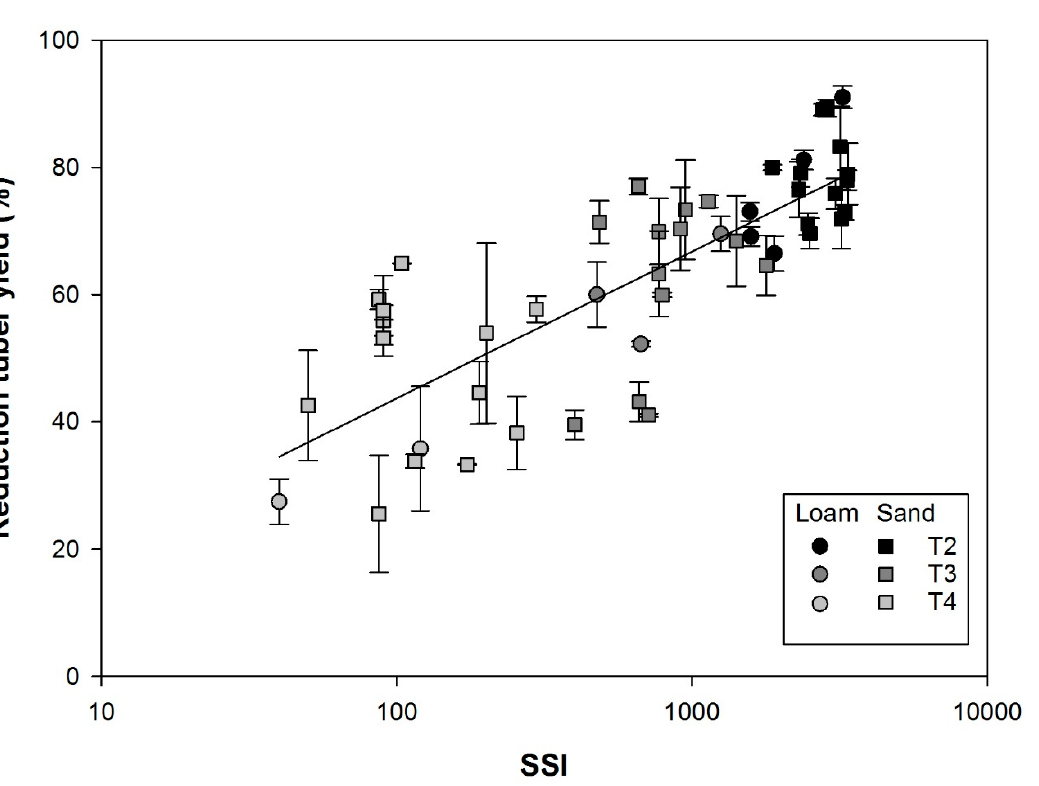
Figure 6. Stress severity index and tuber yield reduction relative to fully irrigated yields for all genotypes (Appendix B), both soil types (Appendix A, and all irrigation treatments (details in Table 2). Linear regression on log transformed x values r 2 = 0.65.